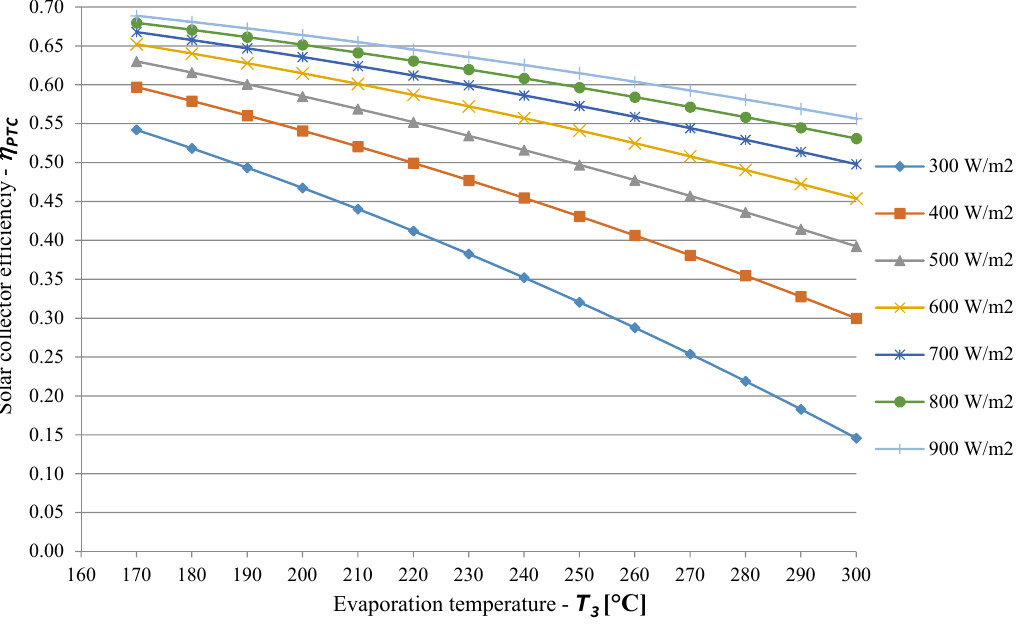
Figure 3. Solar power collection efficiency calculated against the vaporization temperature under rising solar radiation. Reprint with permission [2]; 2020, John Wiley and Sons.